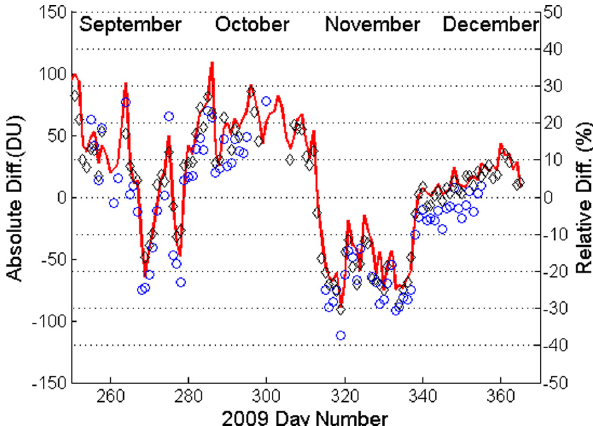
Fig. 2. Differences (absolutes and relatives) of 2009 daily total ozone column with respect to climatological total ozone column for R´ıo Gallegos. Differences with respect to Brewer MkIV spectrom- eter (blue circles) and SAOZ spectrometer (black open diamonds), and OMI satellite measurements (red line) with respect to climato- logical monthly mean. The SAOZ data corresponds to mean sun- rise and sunset values. Data span from the middle of September to the end of December. Absolute differences are calculated as instru- ments (inst) less climatology (clim) (left axis), and relative differ- ences are calculated as (inst − clim)/clim × 100 (right axis).